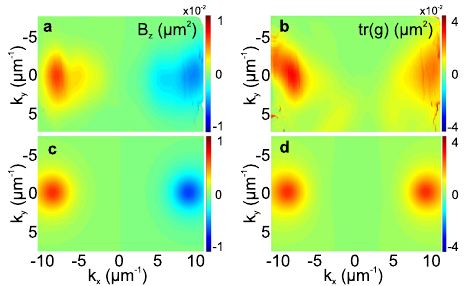
Fig. 4 Experimentally extracted and theoretically calculated Berry curvature and quantum metric. Quantum geometry extracted from the measured Stokes vector: a Berry curvature B z , b trace of the quantum metric g xx + g yy ; Calculated quantum geometry for the lowest eigenstate of (5): c Berry curvature B z , d trace of the quantum metric g xx + g